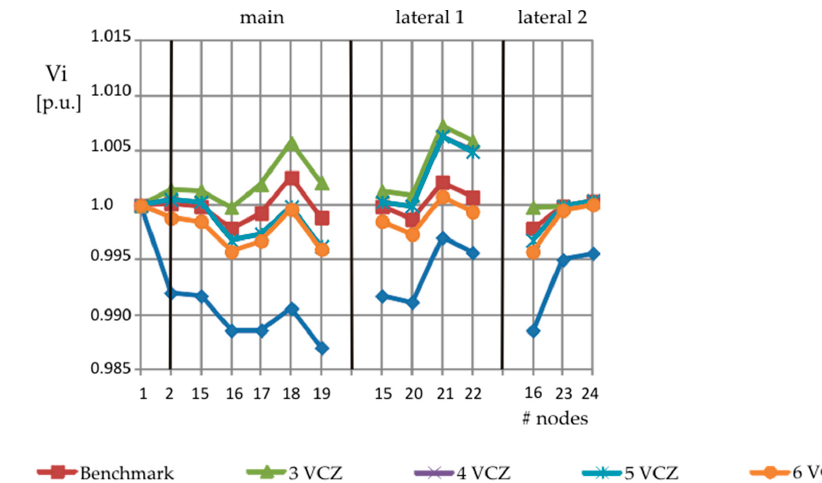
Figure 11 : Voltage profiles for Case R — DG and BESS : Q algorithm—feeder 2.